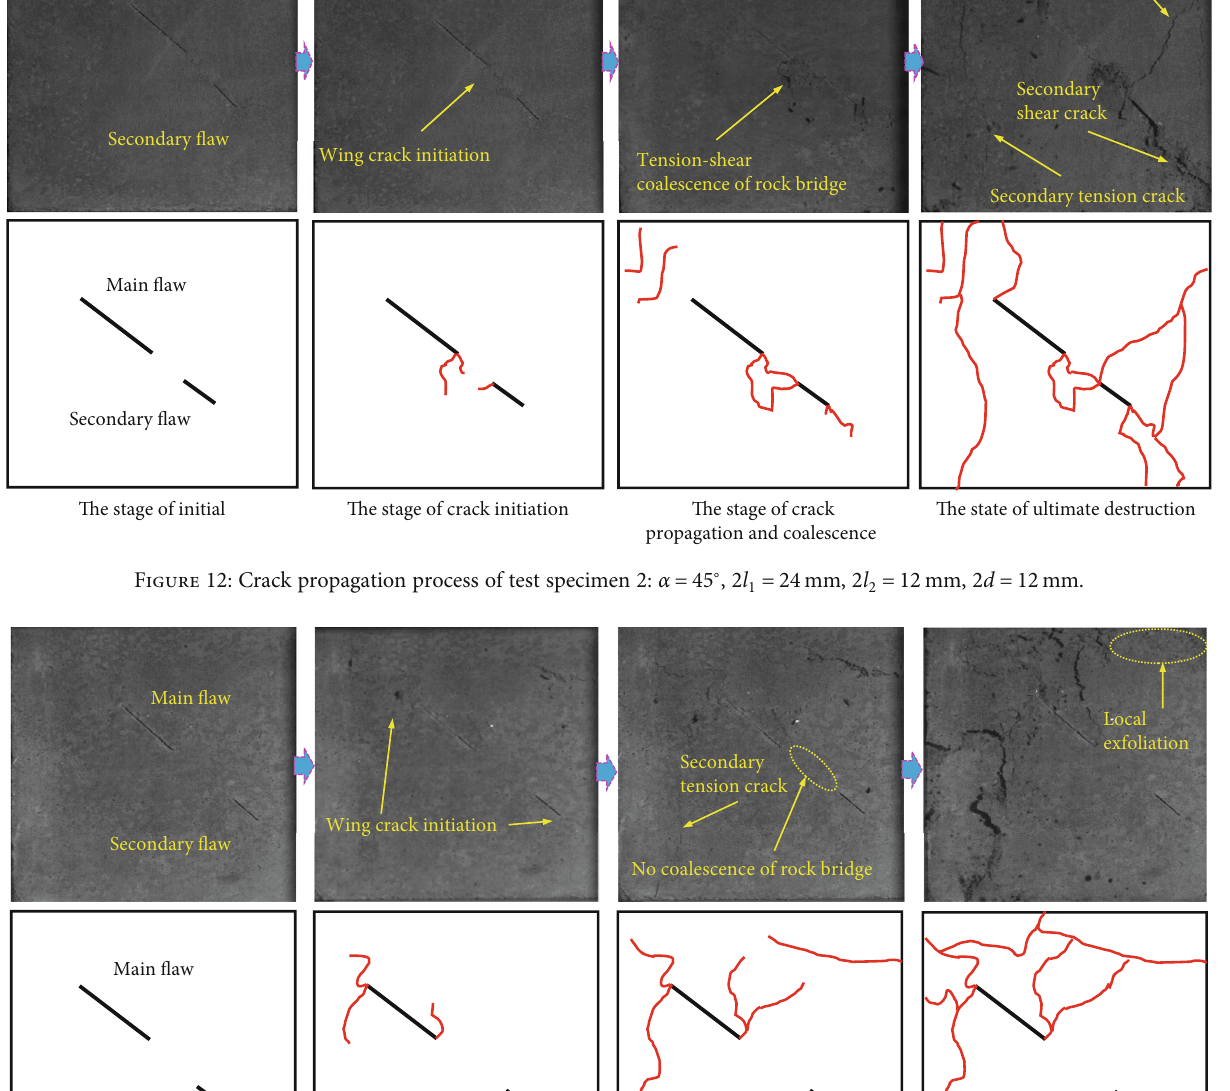
Figure 13: Crack propagation process of test specimen 3: α = 45 ° , 2 l